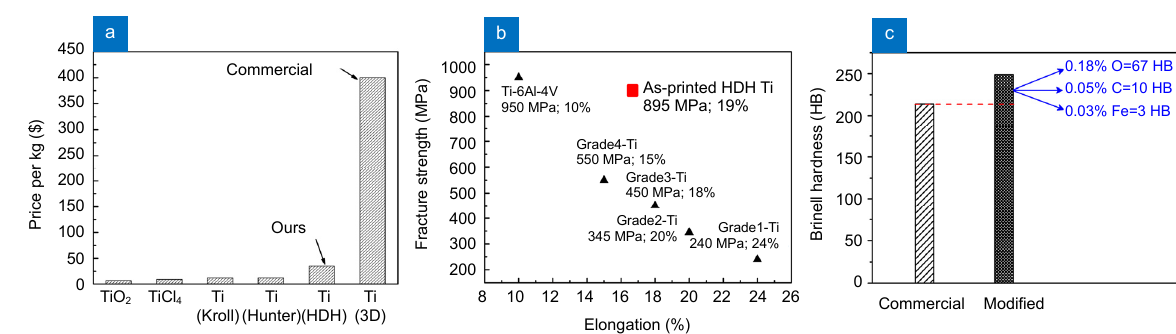
Fig. 5 | ( a ) Comparison of the prices of a variety of Ti materials highlighting the ultralow cost Ti powder developed in this study. ( b ) Comparison of the mechanical properties among some typical Ti materials. ( c ) The Brinell hardness of the as-printed CP-Ti using commercial, spherical powder and modified powder; the latter shows better hardness due to enlarged concentration of N, O and